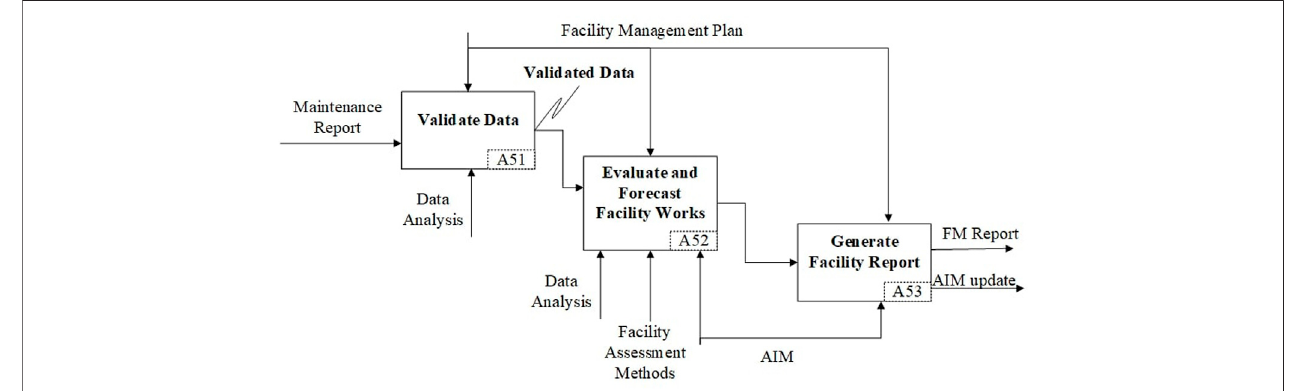
FIGURE 8 | Process model of Control (A5).